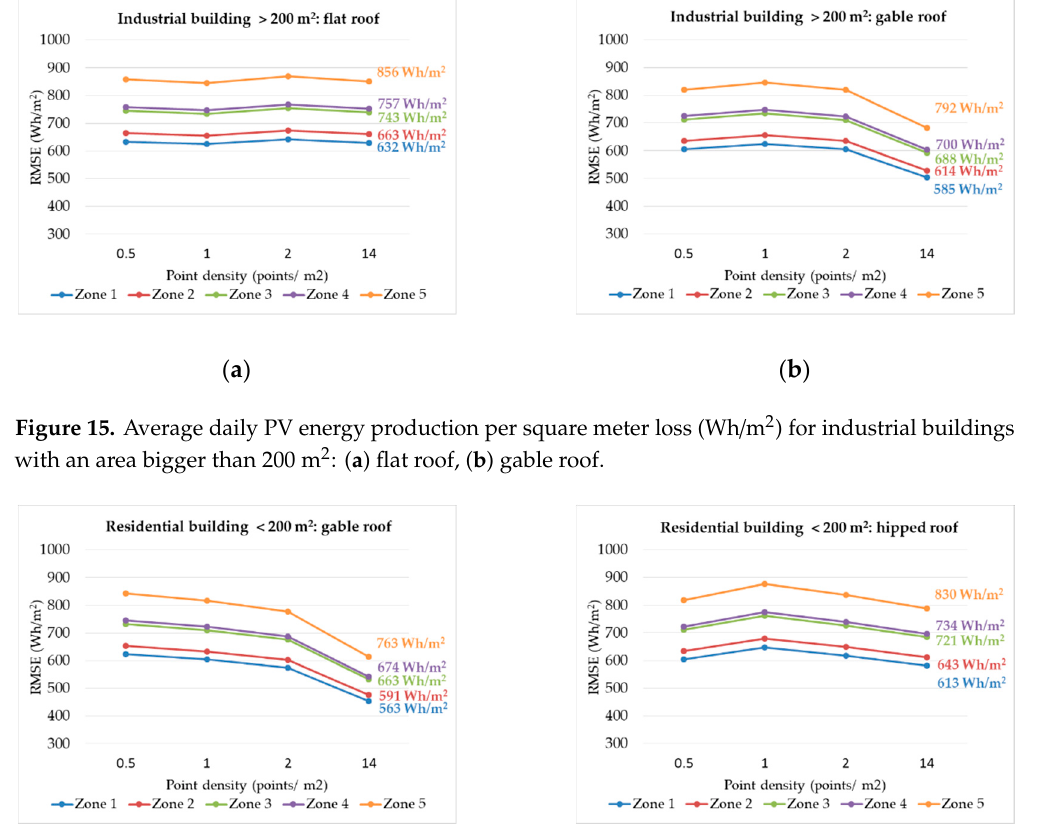
Figure 14. Average daily PV energy production per square meter loss (Wh/m 2 ) for industrial buildings with an area smaller than 200 m 2 : ( a ) flat roof, ( b ) gable roof.